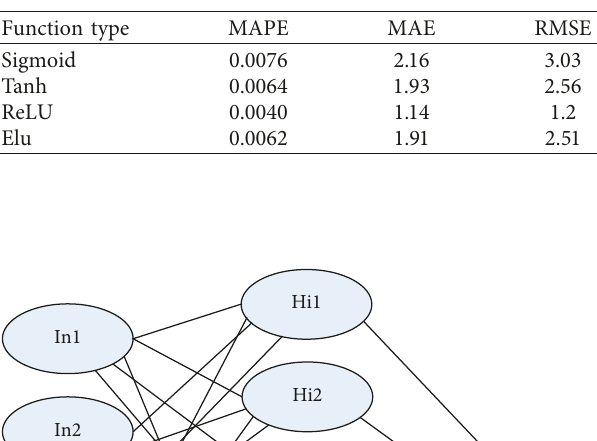
Figure 3: ReLU function image (left) and Elu function image (right). Table 1: Comparison of activation function effects.